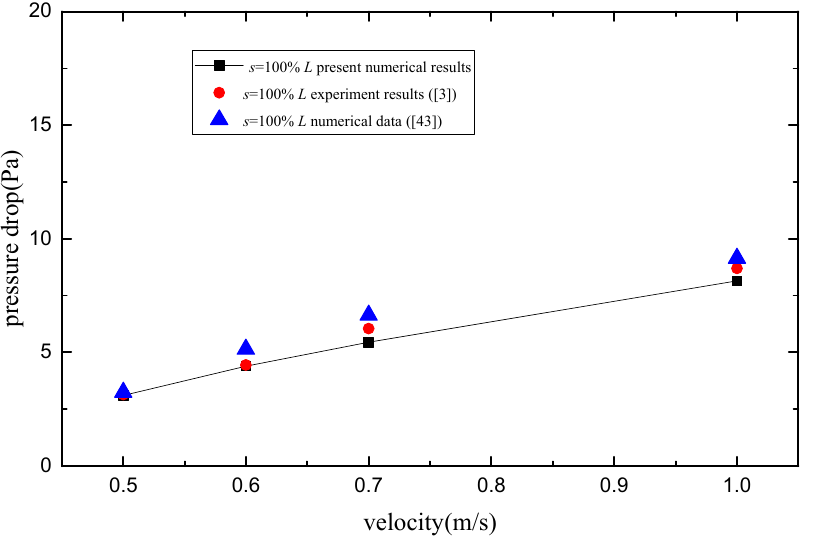
Figure 4. Comparison between the present results and experimental data by Duan and Muzychka [3] and simulation results by Kim et al. [43].